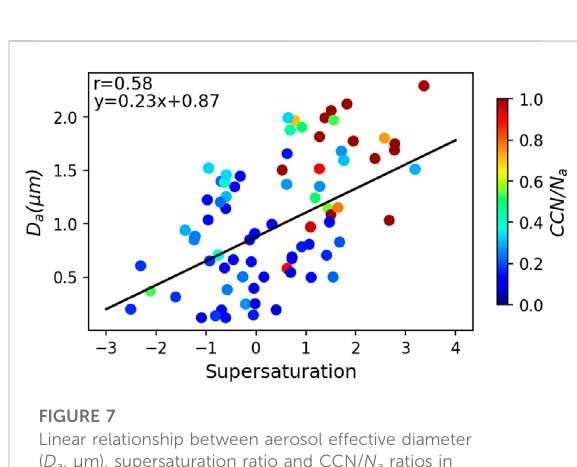
FIGURE 7 Linear relationship between aerosol effective diameter ( D a , µm), supersaturation ratio and CCN/ N a ratios in 2500 – 3000 m.